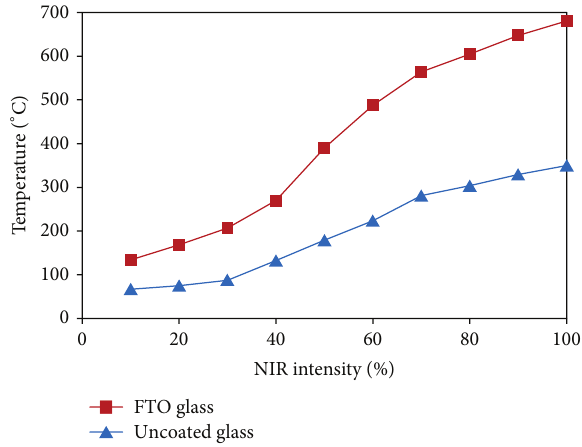
Figure 2: Temperature of FTO glass and uncoated glass after 12.5s of NIR exposure at varying NIR intensities.